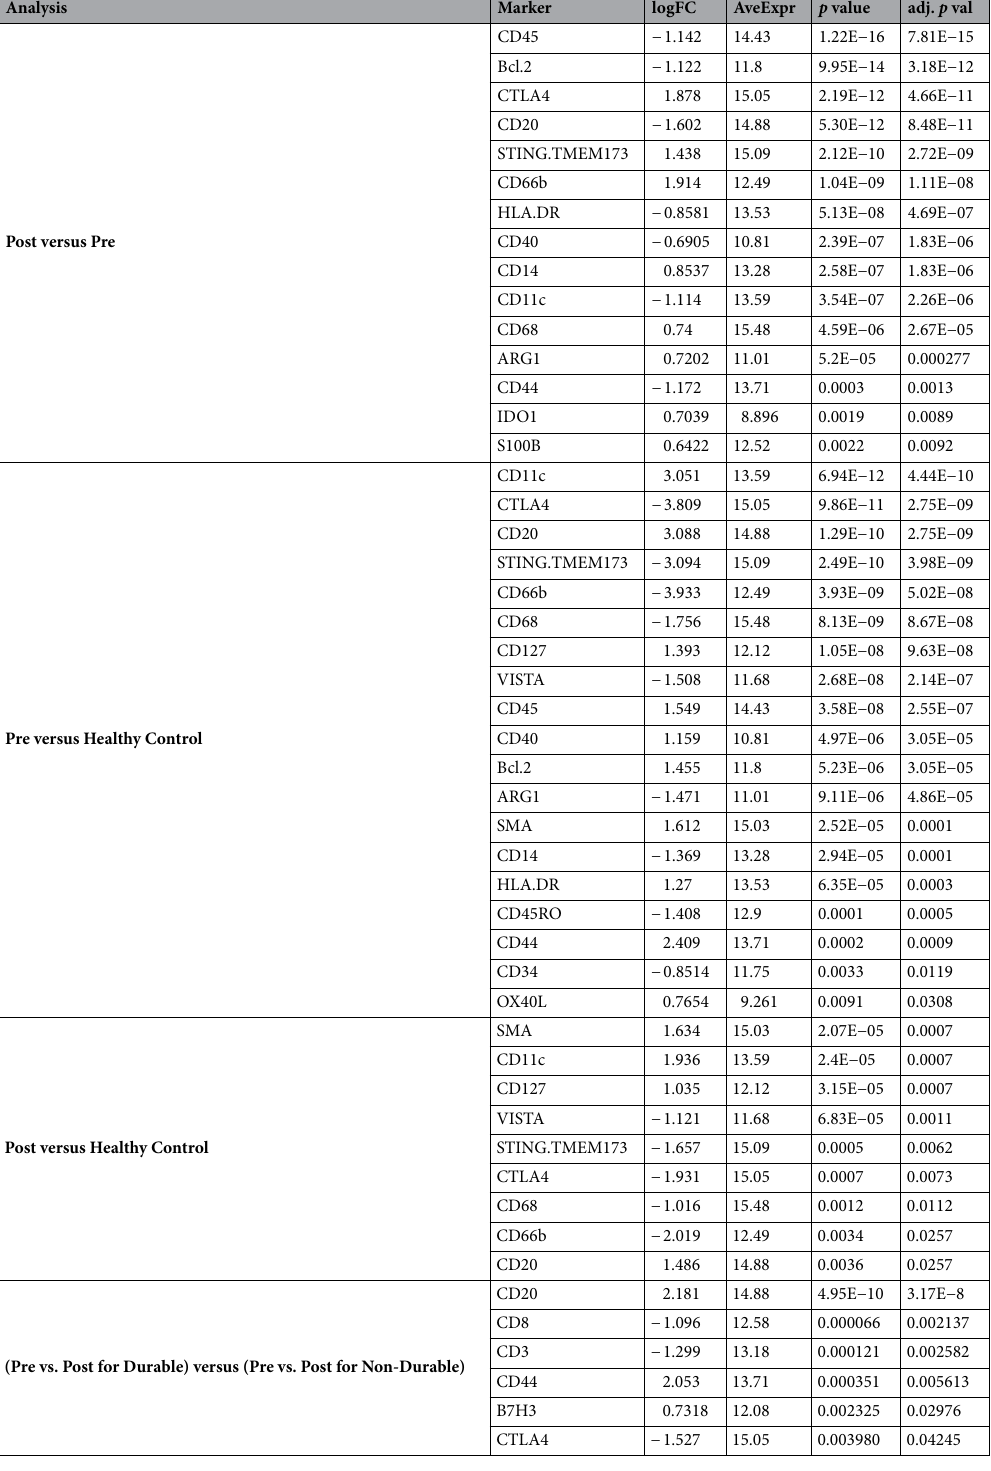
Table 1. Multivariate analysis